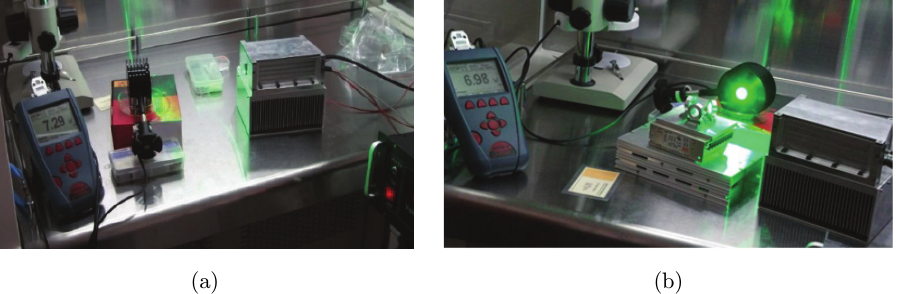
Fig. 6. Preliminaryexperimentsusingthe532-nmlaser:(a)withouta¯lterand(b)with940-nmanti-re°ectionand a532-nmhigh¯lter.